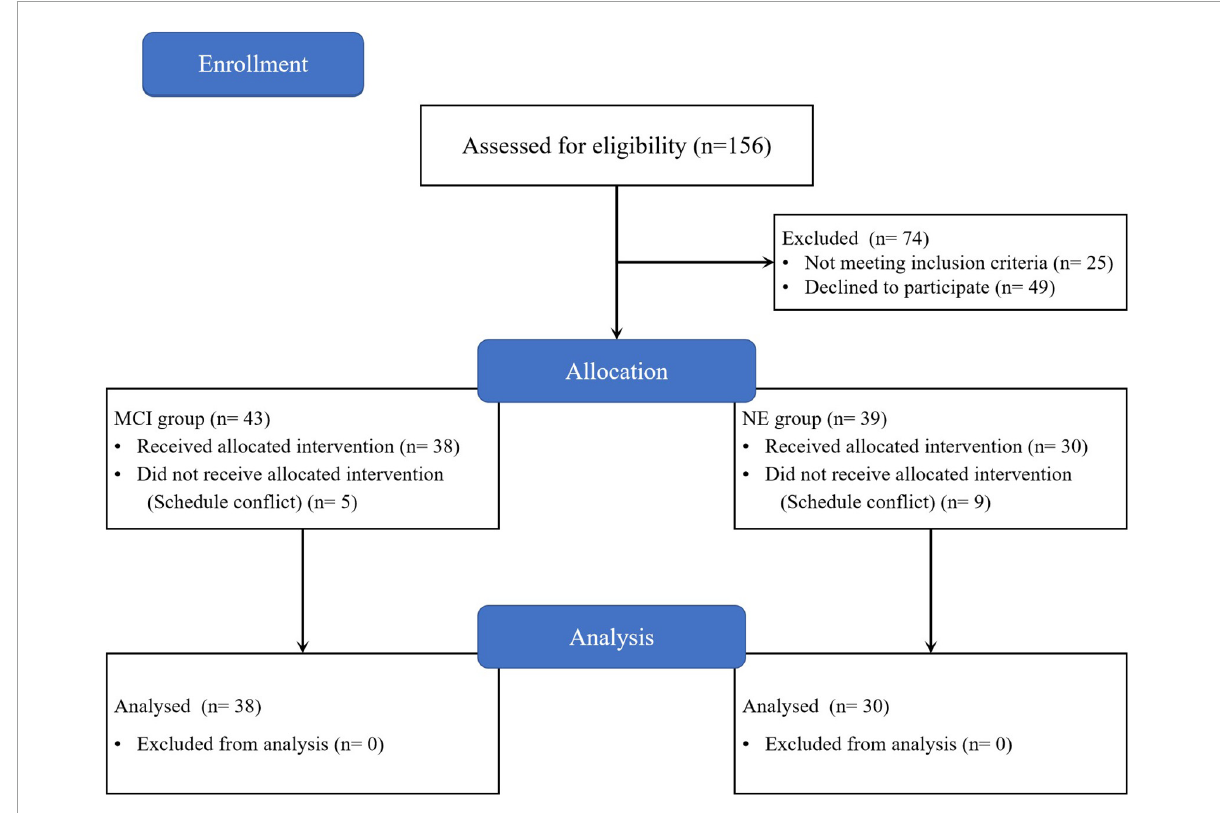
FIGURE1 Study flow diagram. NE, normal elder; MCI, mild cognitive